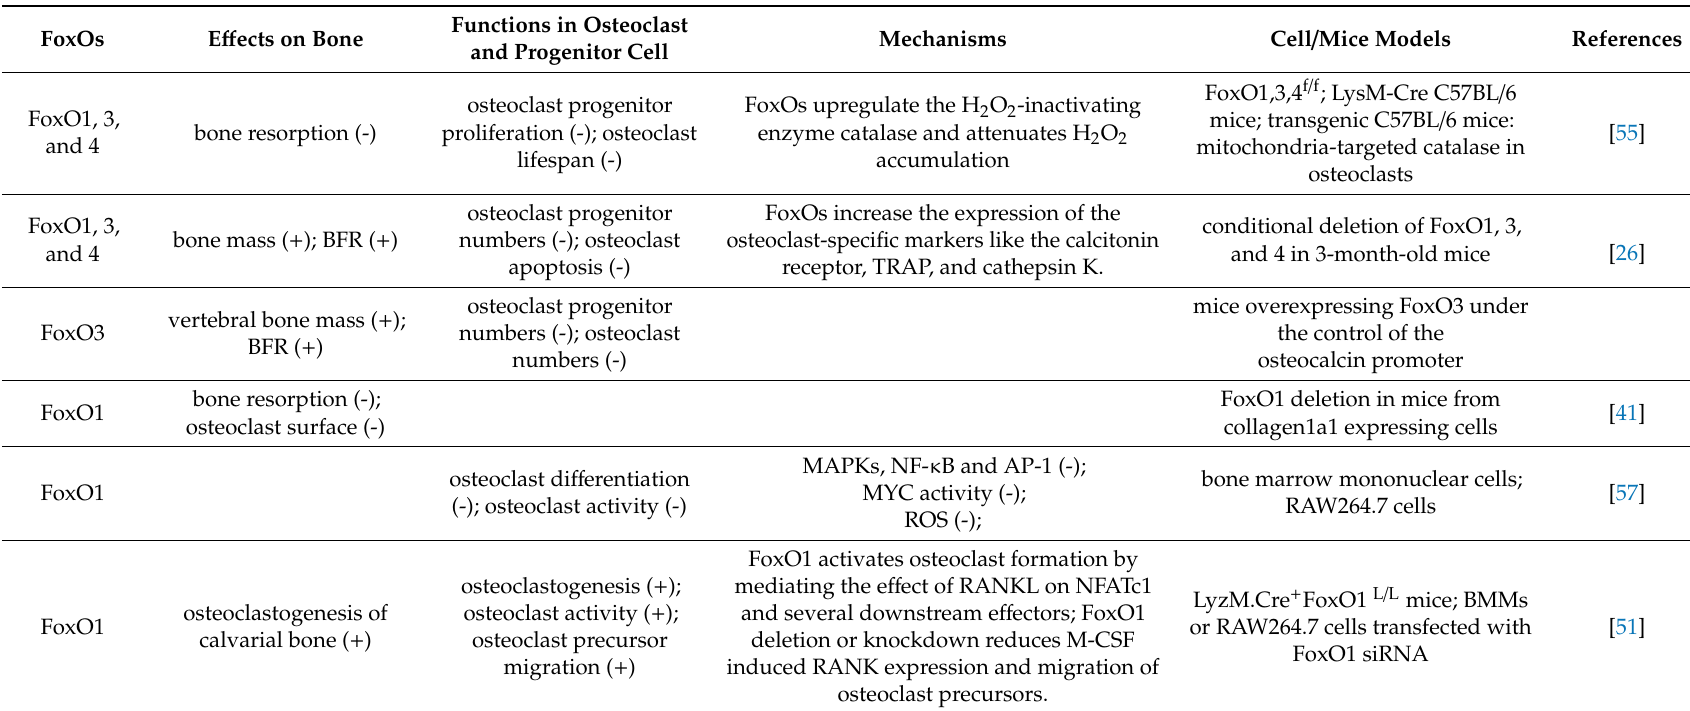
Table 4. Bone metabolism regulatory functions of FoxO transcription factors in osteoclast and progenitor